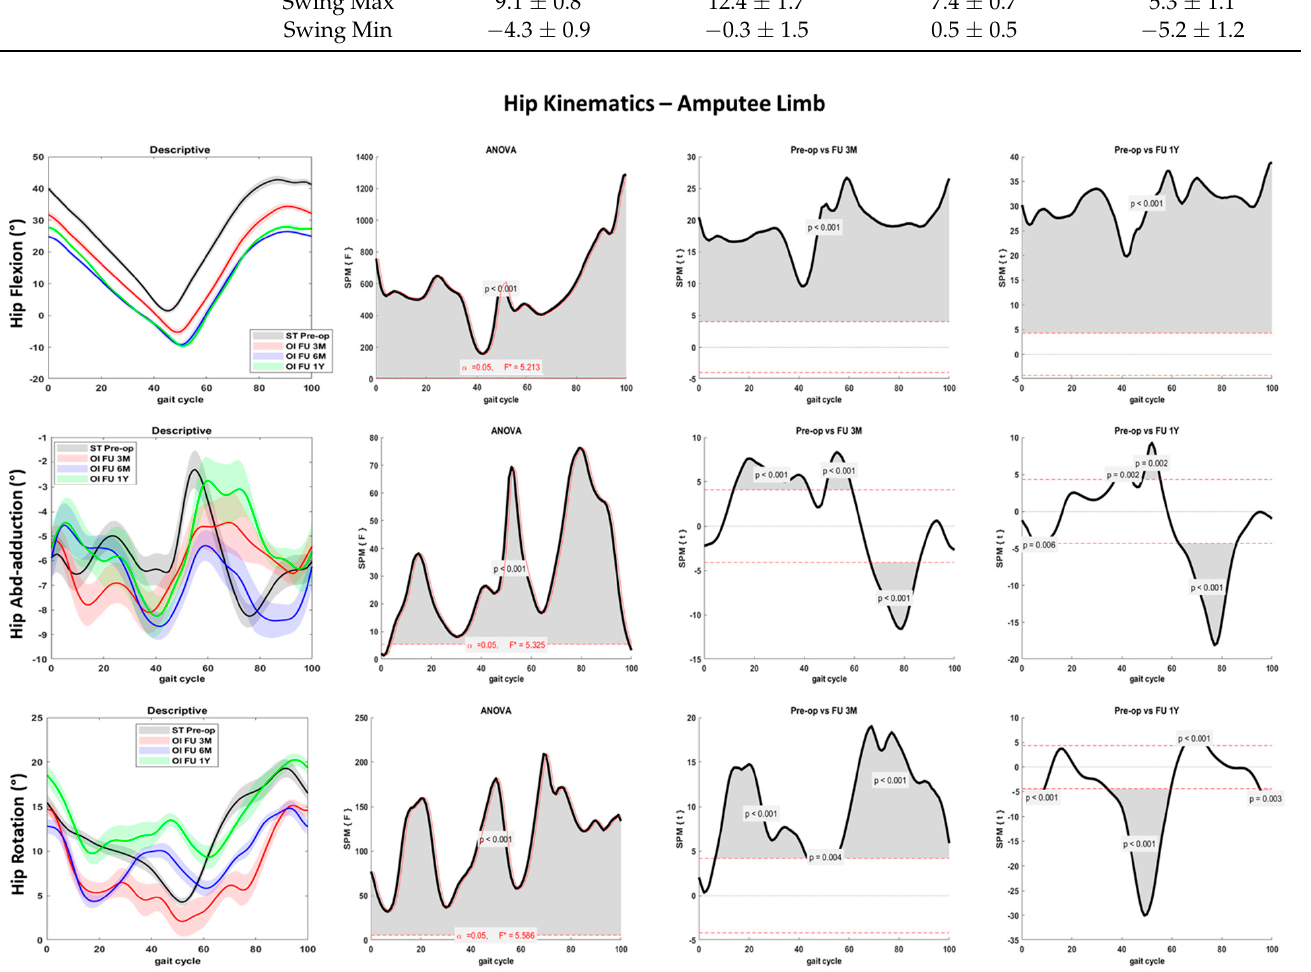
Figure 4. Hip joint kinematics for the amputee limb over the percentage of the gait cycle for the fast gait in sagi tt al ( fi rst row), frontal (second row), and transverse (third row) planes. Descriptive data ( fi rst column) are expressed as mean (solid line) and standard deviation (dashed line). The gray line represents pre-operative gait analysis with socket-type prosthesis (ST pre-op), the red line represents gait analysis at 3 months follow-up with osseointegrated prosthesis (OI FU 3M), the blue line represents gait analysis at 6 months follow-up with osseointegrated prosthesis (OI FU 6M), the green line represents gait analysis at 1-year follow-up with osseointegrated prosthesis (OI FU 1Y). The results of the spm1D repeated-measure ANOVA are presented in the second column. Gray areas represent statistically signi fi cant di ff erences ( p < 0.05) among the groups. The di ff erences between pre-operative phase and either 3 months follow-up (third column) or 1-year follow-up (fourth column) were assessed through t-test with Bonferroni correction.